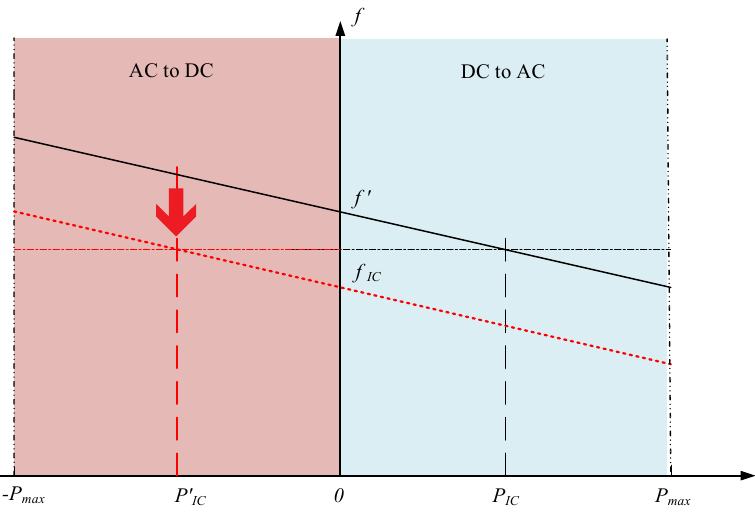
Figure 9. Bi-directional static P - f control of a hybrid microgrid.